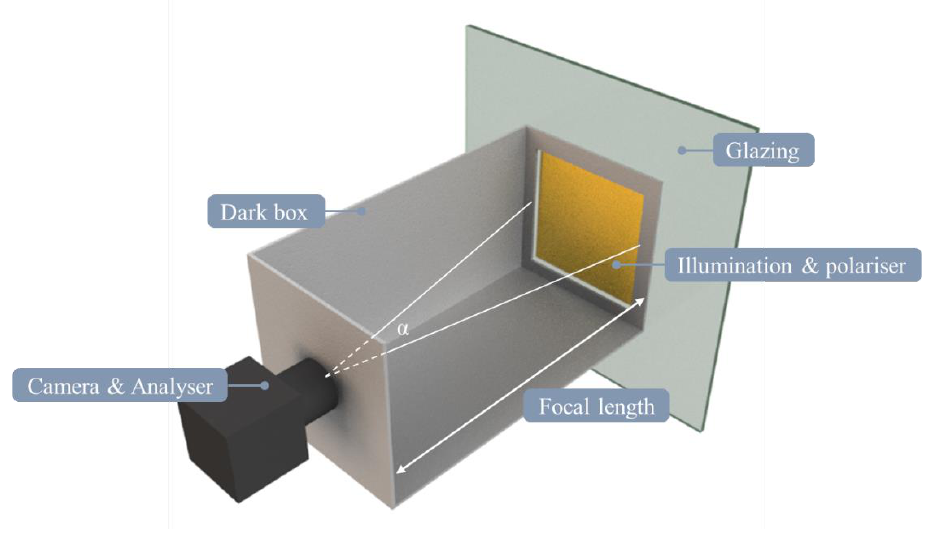
Fig. 12 Schematic of modified